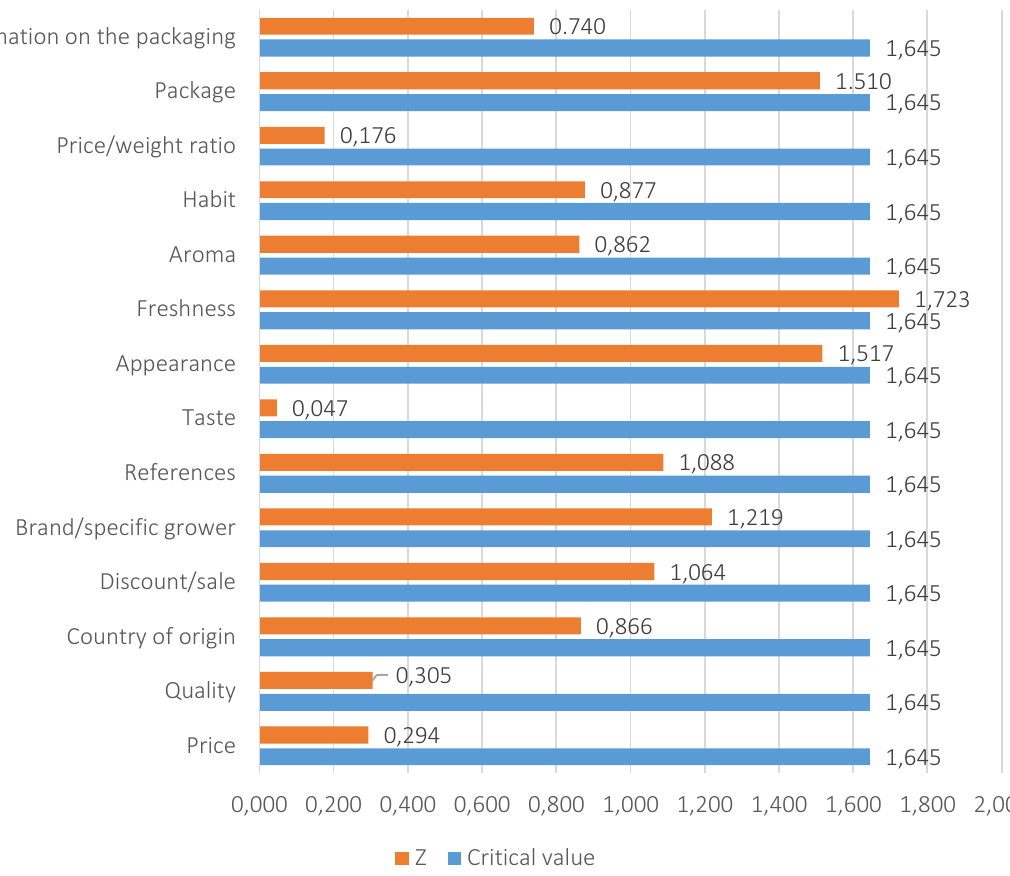
Figure 7. Mann-Whitney U test results according to each Table 4. Summary of tested hypotheses